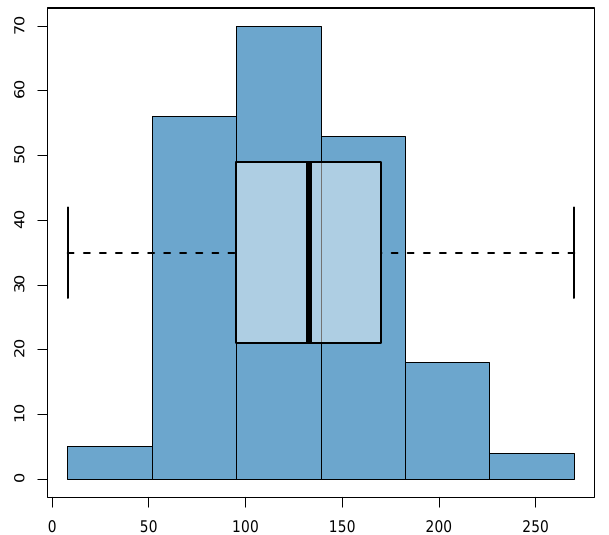
Figure 7. Boxplot and histogram of the durations of the treatments. Axis X : durations of the treatments in minutes. Axis Y : number of patients.